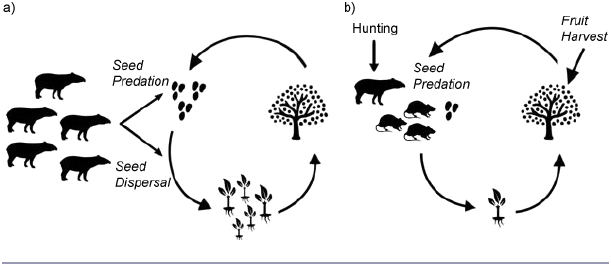
Fig. 2 . The interactions between fruit production, seed predation, seed dispersal, and recruitment (a), and how these are altered through nontimber forest product (NTFP) use of either fruits, seeds, or hunting of vertebrate dispersers